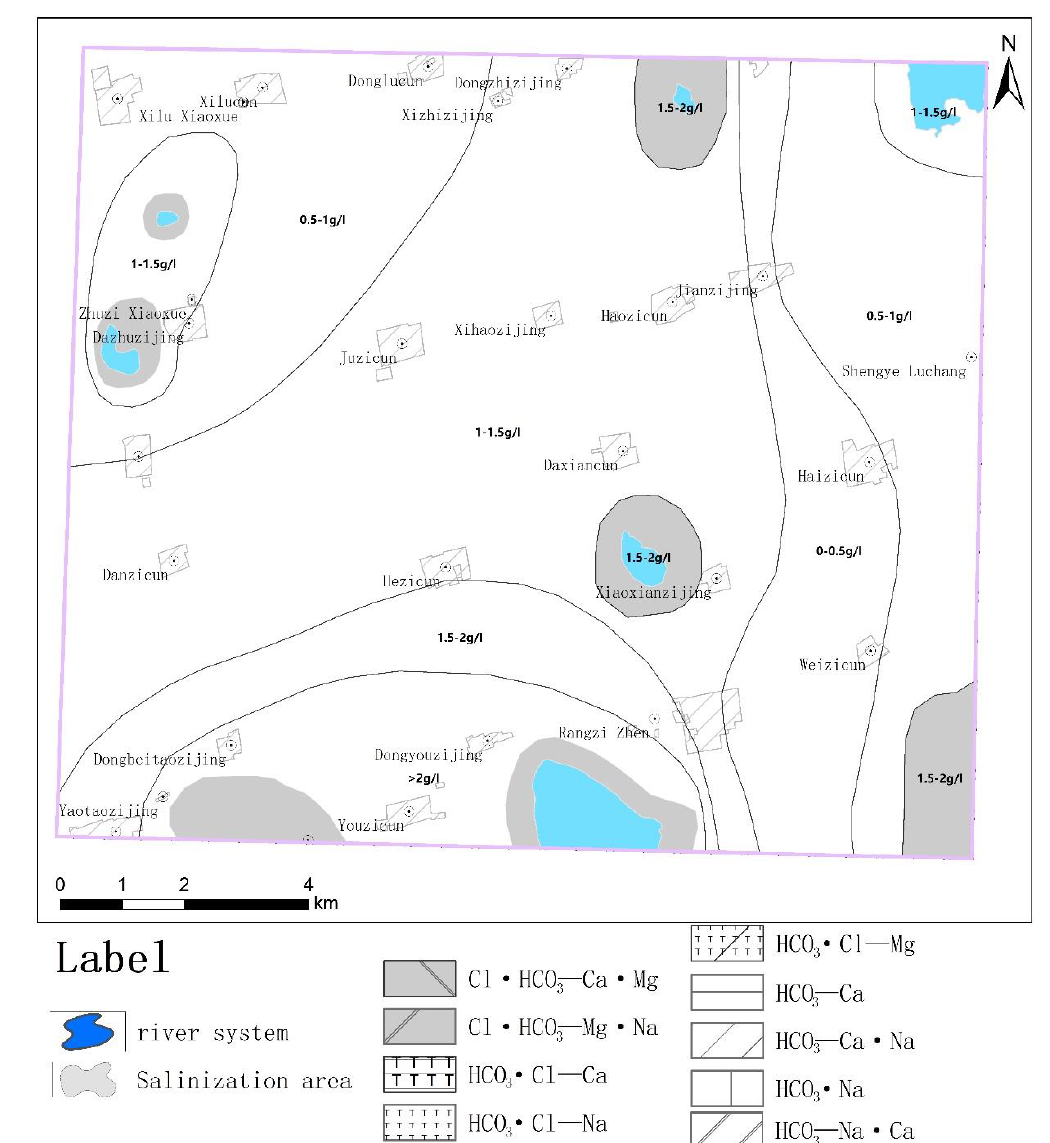
Figure 5. Zoning of groundwater salinity in the study